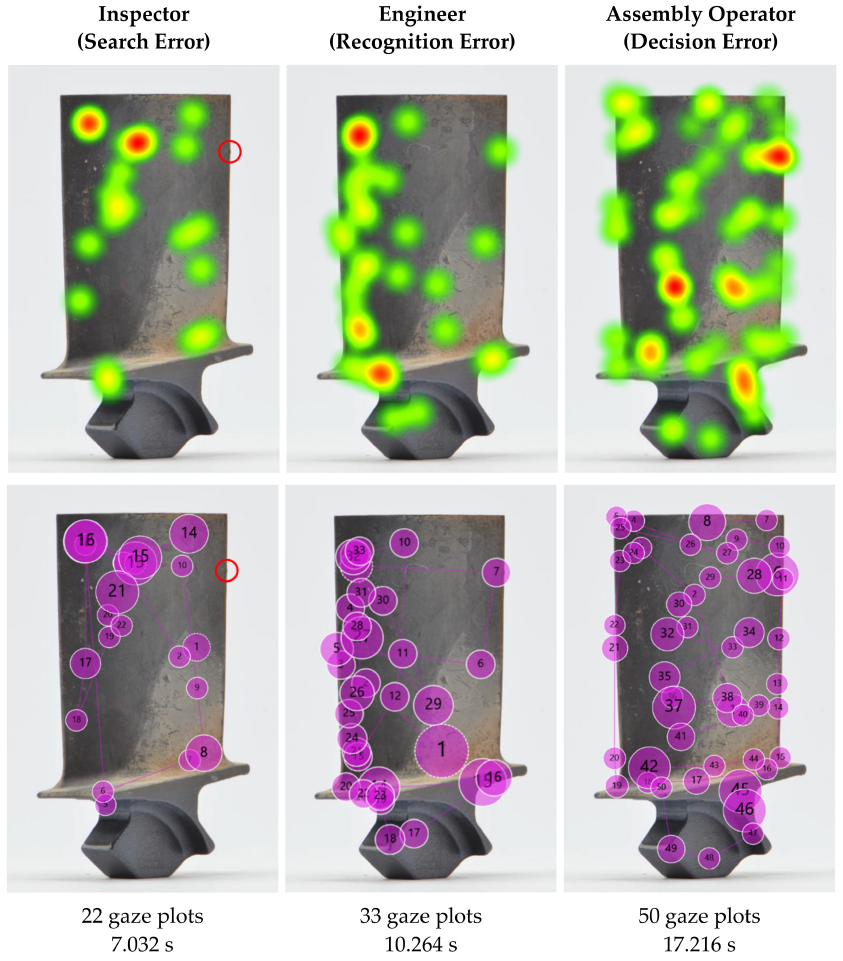
Figure 23. Eye tracking results for each level of expertise, highlighting the predominant inspection error. Defect indicated by red